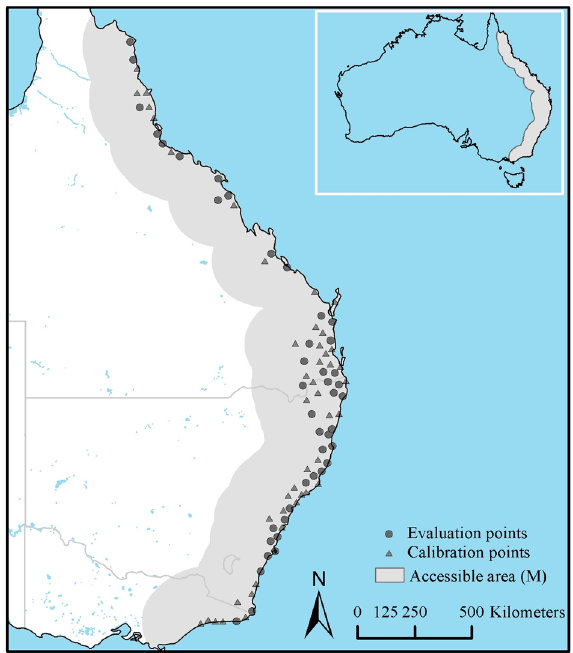
Figure 1. Rarefied occurrence data used for niche model calibration and evaluation, and the areas accessible ( M ) to Ixodes holocyclus through natural